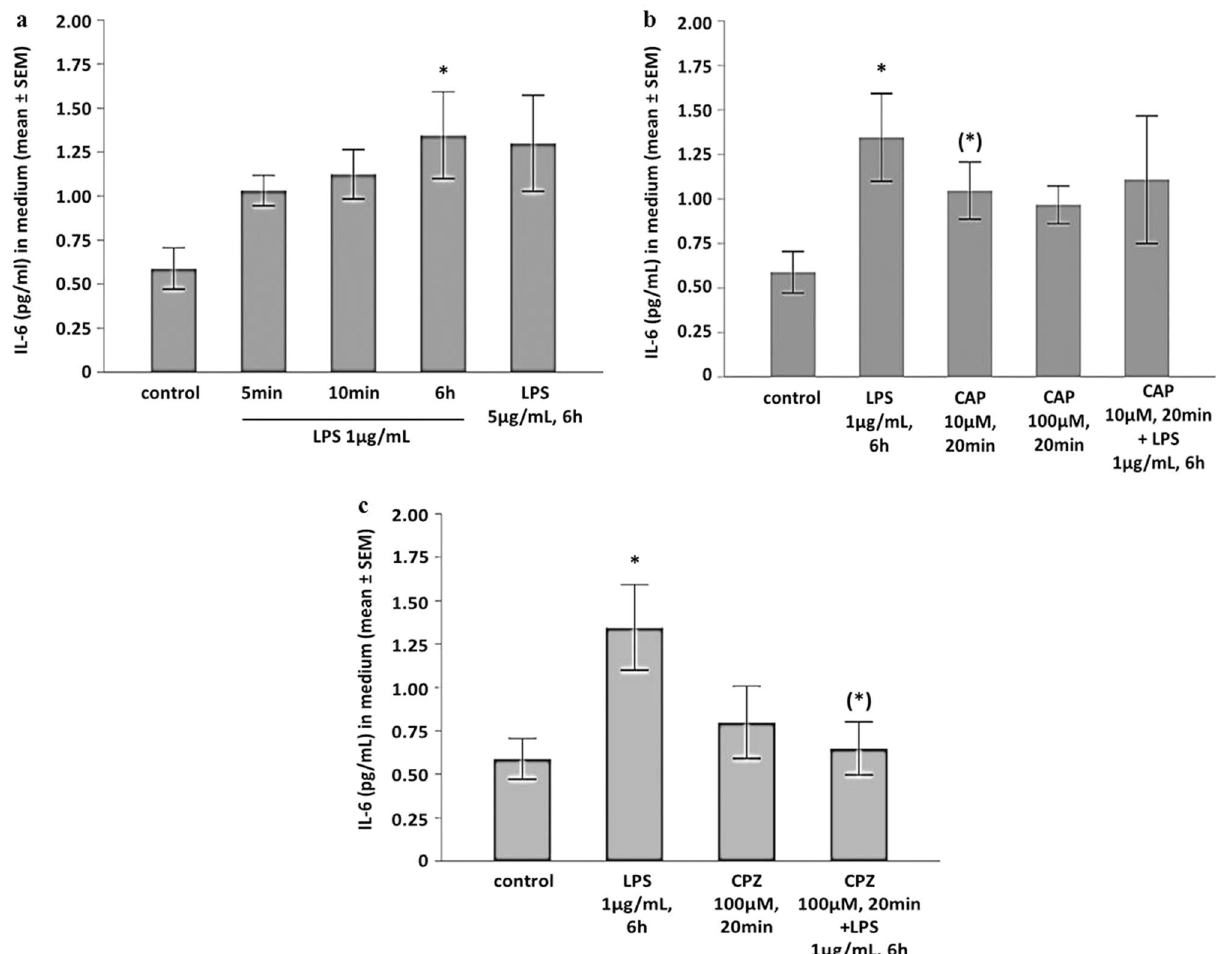
Figure 3. ( a ) LPS induces the release of interleukin-6 into the cell culture medium (mean ± standard error of the mean (SEM)). Kruskal–Wallis p = 0.0136; * p < 0.01 LPS 1 µg/mL, 6 h, versus unstimulated controls. Unstimulated cells, n = 16, n = 5 independent experiments, n = 1–5 biological replicates per experiment. LPS 1 µg/mL, 6 h, n = 15, n = 5 independent experiments, n = 1–7 biological replicates per experiment. LPS 1 µg/ mL, 5 or 10 min, n = 3, n = 1 independent experiment, n = 3 biological replicates. LPS 5 µg/mL, n = 5, n = 4 independent experiments, n = 1–2 biological replicates per experiment. ( b ) Capsaicin (CAP, 10 µM, 20 min) mediates a non-significant release of interleukin-6 which is lower than the LPS-induced interleukin-6 production (LPS, 1 µg/mL, 6 h). Capsaicin (100 µM, 5 min) does not have an effect on interleukin-6 release. Presented is the mean ± standard error of the mean (SEM). Kruskal–Wallis p = 0.037; * p < 0.05 LPS versus unstimulated controls; (*) p < 0.1 CAP 10 µM versus unstimulated controls. Unstimulated cells, n = 16, n = 5 independent experiments, n = 1–5 biological replicates per experiment. LPS 1 µg/mL, 6 h, n = 15, n = 5 independent experiments, n = 1–7 biological replicates per experiment. CAP 10 µM, n = 9, n = 4 independent experiments, n = 1–5 biological replicates per experiment. CAP 100 µM, n = 3, n = 1 independent experiment, n = 3 biological replicates. CAP + LPS, n = 5, n = 3 independent experiments, n = 1–3 biological replicates per experiment. ( c ) Capsazepine (CPZ, 100 µM, 20 min) prevents LPS-induced interleukin-6 secretion. Presented is the mean ± standard error of the mean (SEM). Kruskal–Wallis p = 0.017; * p < 0.01 LPS versus unstimulated controls, (*) p < 0.1 CPZ + LPS versus LPS. Unstimulated cells, n = 16, n = 5 independent experiments, n = 1–5 biological replicates per experiment. LPS 1 µg/mL, 6 h, n = 15, n = 5 independent experiments, n = 1–7 biological replicates per experiment. CPZ, n = 6, n = 4 independent experiments, n = 1–2 biological replicates per experiment. CPZ + LPS, n = 7, n = 4 independent experiments, n = 1–4 biological replicates per and HEK293 cells 15 . We therefore hypothesized that the exposure of hiPSC-CMs to LPS would lead to TRPV1 internalization on these cells as well. Indeed, analysis of the fluorescence intensity of TRPV1 using immunofluo- rescence demonstrated reduction of the TRPV1 channel density after incubation with LPS (1 µg/mL, 6 h; Fig. 4). Long‑term inflammation leads to prolonged impairment of TRPV1 ion channel current. Pro- longed TRPV1 activation by an agonist leads to the reduction of calcium influx via the channel, paralleled by the degradation of the channel 15 . We therefore tested whether prolonged LPS incubation would alter TRPV1-associ-